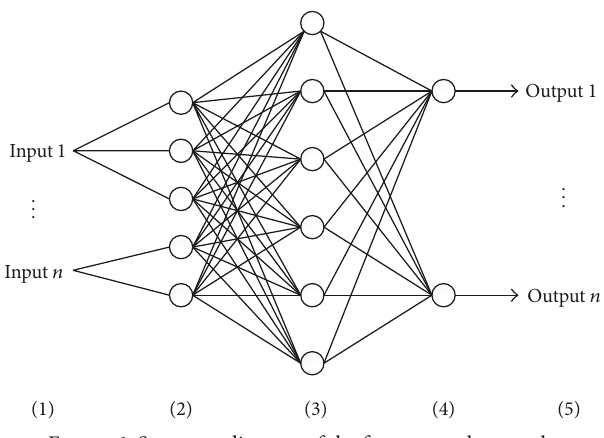
Figure 1: Structure diagram of the fuzzy neural network.